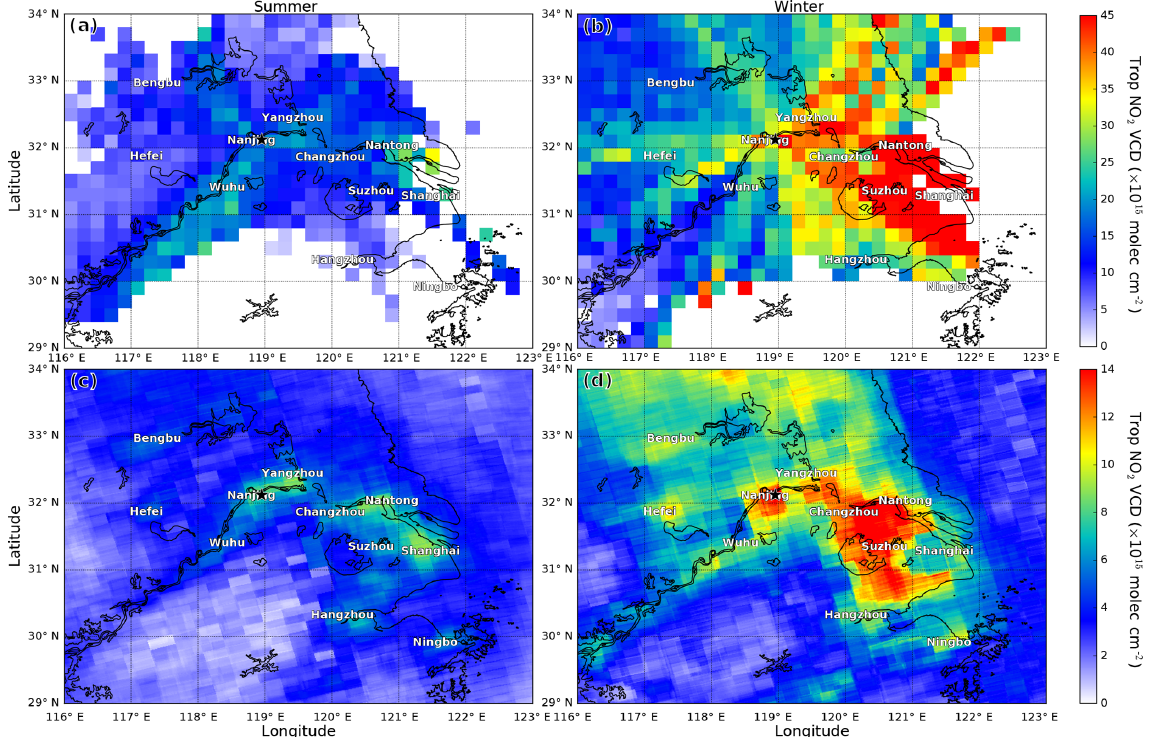
Figure 8. The upper panels show spatial distribution of NO 2 in (a) summer and (b) winter reconstructed from the MAX-DOAS measurements using backward trajectories calculated by the HYSPLIT model. Backward trajectories are calculated over 6h for summer measurements and 12h for winter measurements. The lower panels indicates the average OMI NO 2 vertical column densities over the Yangtze River Delta during (c) summer and (d)